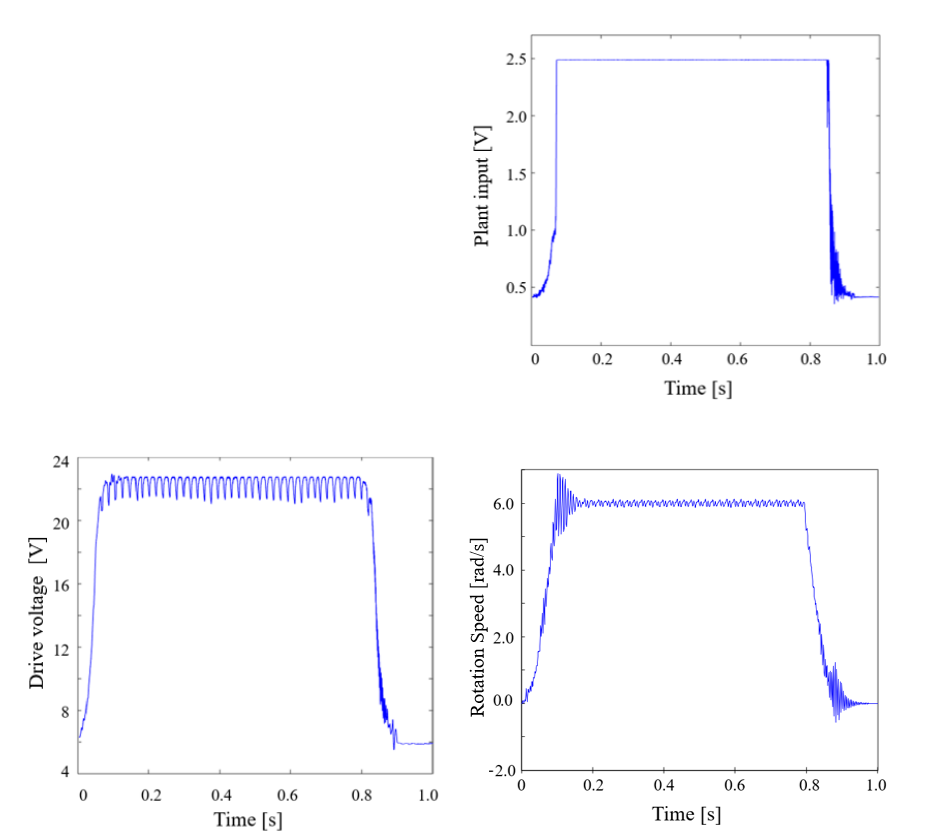
Figure 10. Responses of the analog